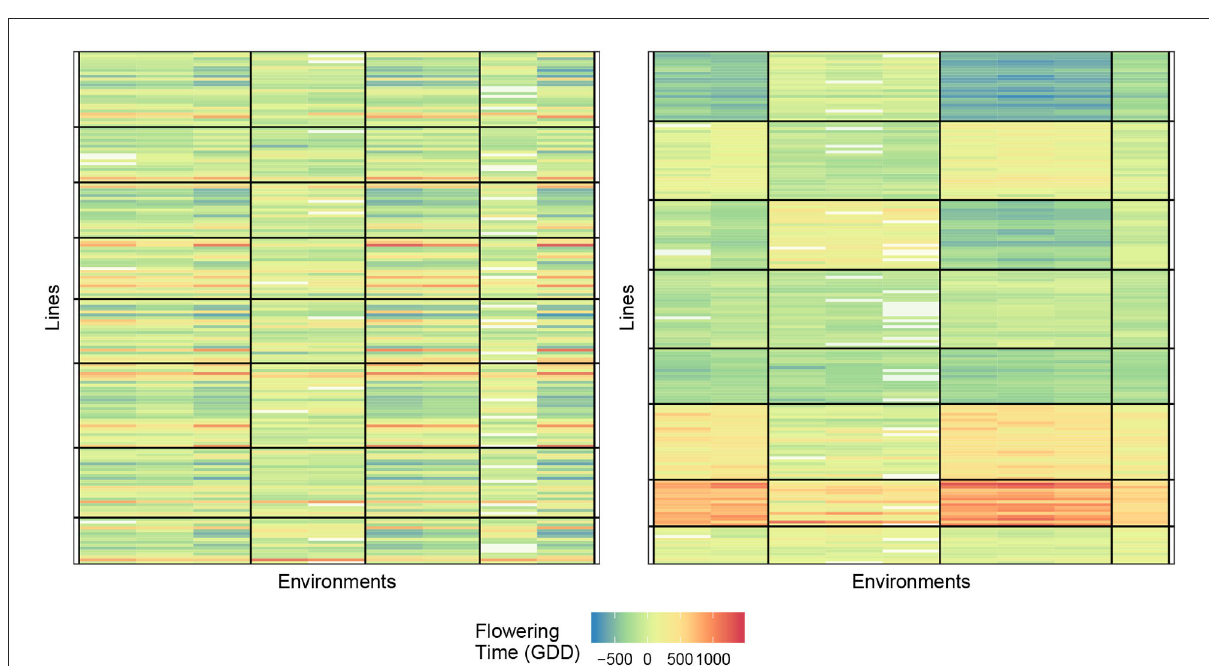
FIGURE5 Biclustering illustration of response (4) with initialization (left) and final bicluster (right) for eight rows and four column clusters (rice data). The homogeneity of the cells indicates that the biclustering algorithm was able to successfully group the response variables in distinct clusterings.